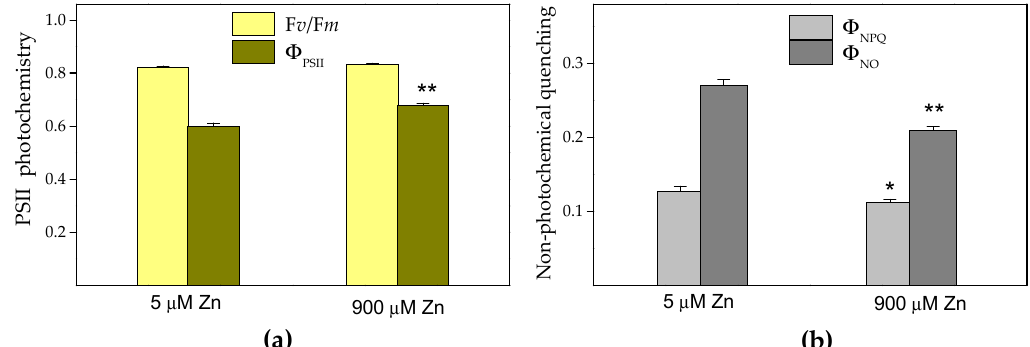
Figure 6. Changes in the maximum efficiency of the photosystem II (PSII) photochemistry (F v /F m ) and the quantum efficiency of the PSII photochemistry ( Φ PSII ) ( a ), as well as in the quantum yield of regulated energy dissipation in PSII ( Φ NPQ ) and in the quantum yield of nonregulated energy dissipation in PSII ( Φ NO ) ( b ), of Salvia sclarea leaves after exposure to 5 µM (control) or 900 µM (excess) Zn for 8 days. Mean values (±SE) were compared between the two treatments for the same parameter using a Student’s t- test, and the differences were considered statistically significant with * p < 0.05 or ** p < 0.01.